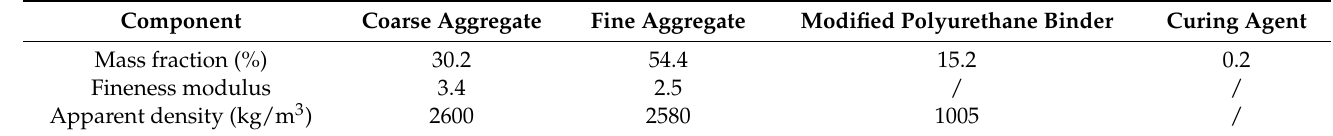
Table 2. Mix proportion of modified polyurethane concrete.